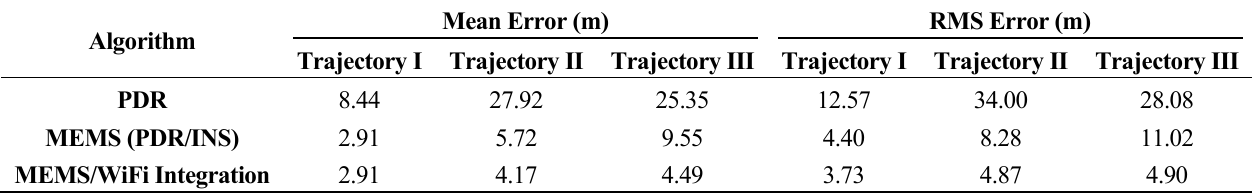
Table 4. Summary of positioning performance in three